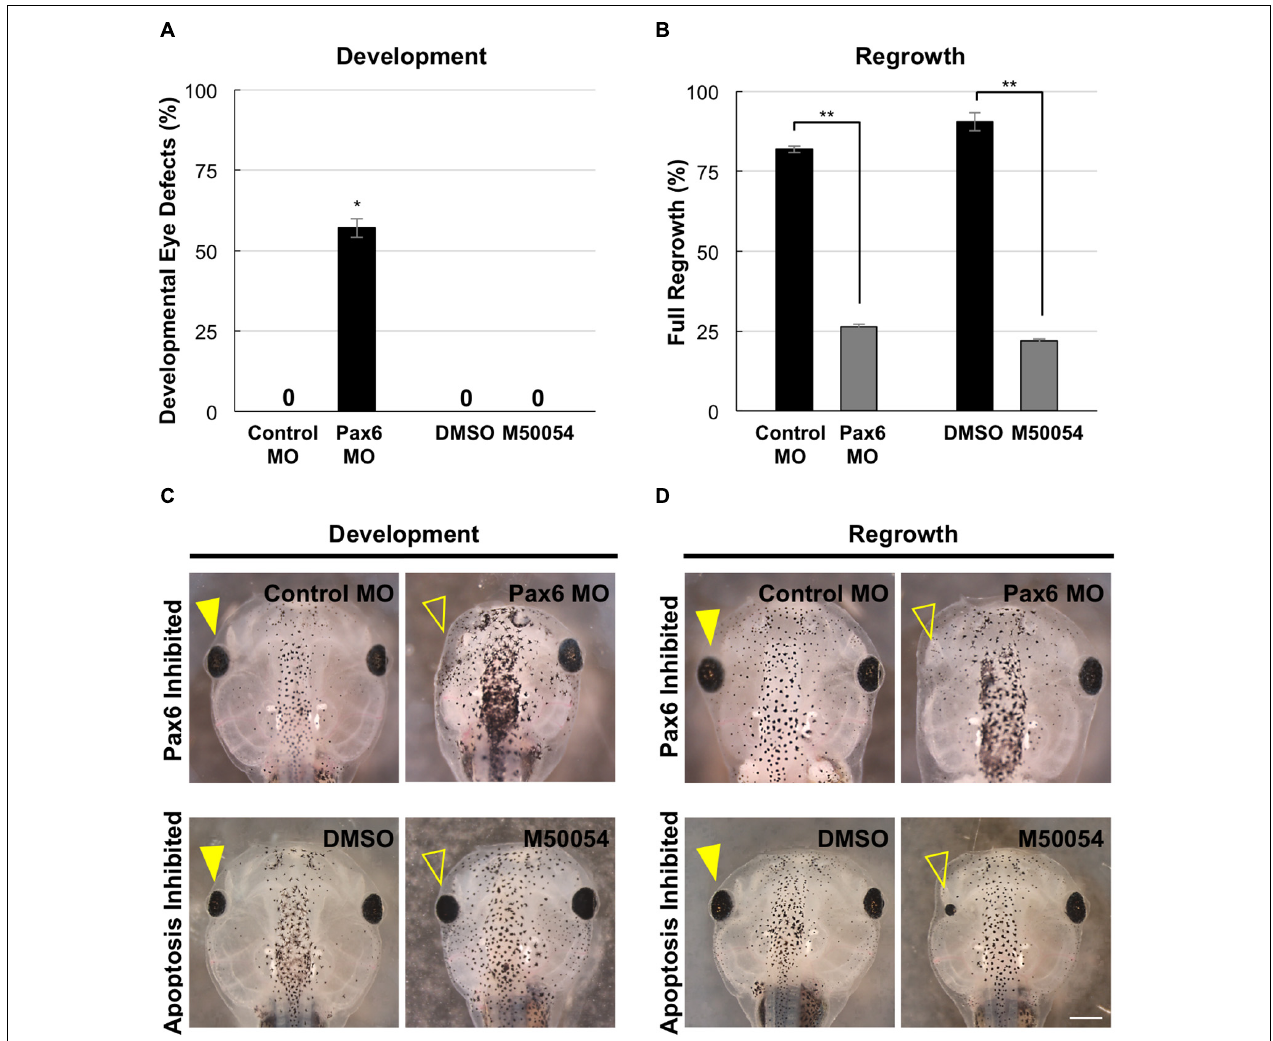
FIGURE 7 | Development and regrowth require Pax6, but only regrowth requires apoptosis. (A) Comparison of developmental eye defects percentage from embryos injected at the 4-cell stage (1 blastomere) with either the control or Pax6 morpholino or treated with DMSO control or M50054 at st. 10. A zero denotes no abnormal phenotype in the control by st. 27. ∗ denotes p < 0.05 ( n > 90). Data are means ± SEM. (B) Graphical representation of tadpoles achieving full eye regrowth at 5 dps (st. 46) with morpholino injection or apoptosis inhibitor treatment. ∗∗ denotes p < 0.01 ( n > 20). Data are means ± SEM. (C,D) Comparison of requirements for eye development and regrowth. (C) Pax6 morpholino injected tadpoles show reduced eyes when compared to the control by st. 46 in development. Apoptosis inhibitor show no effect on eye development ( n > 30 per condition). Closed yellow arrowhead indicates eye of control, untreated tadpole. Open yellow arrowhead indicates eye of treated tadpole. (D) Pax6 morpholino and apoptosis inhibitor affects eye regrowth ( n > 30). Closed yellow arrowhead indicates the eye of a control, untreated tadpole. Open yellow arrowhead indicates the eye of an inhibitor treated tadpole. (C,D) Up = anterior, down = posterior. Scale bar: C,D = 500 µ